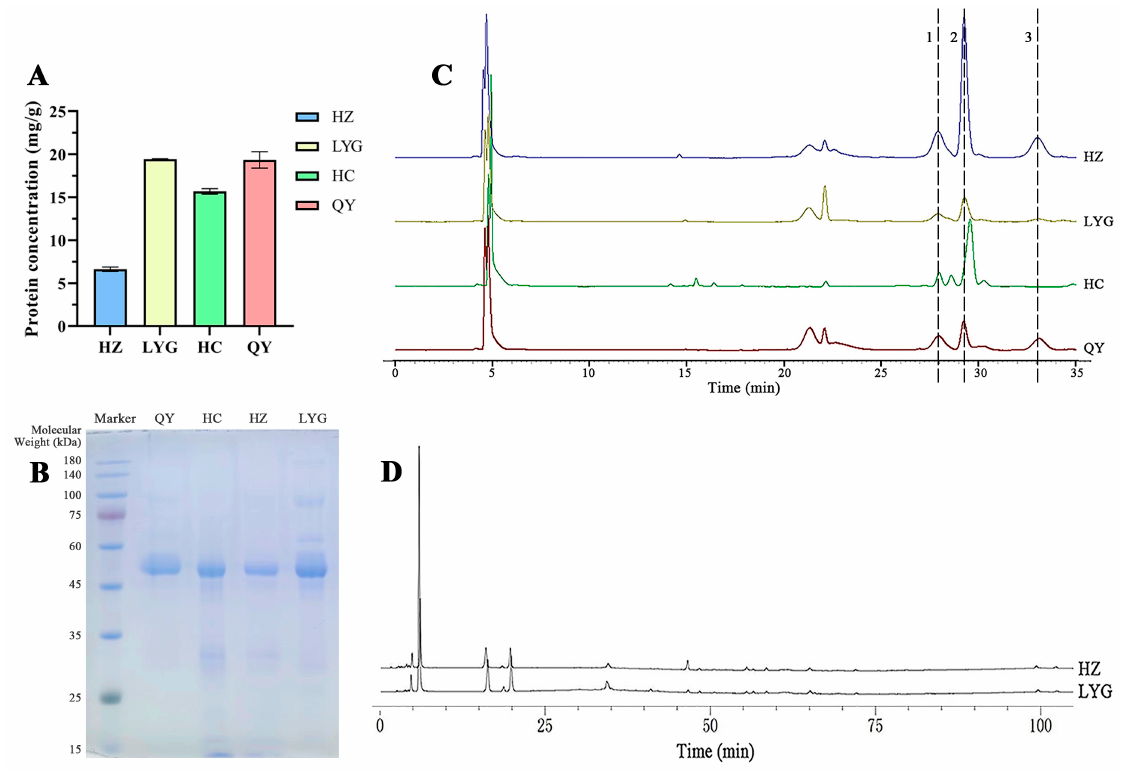
Figure 2. Composition differences between small molecular components and protein components of the venom of toads from different areas. ( A ) Protein quantification of toad venom from four areas. ( B ) Sodium dodecyl sulfate-polyacrylamide gel electrophoresis results of toad venom from four areas. ( C ) HPLC fingerprints of small molecular components of toad venom from four areas. 1: bufalin, 2: cinobufagin, 3: resibufogenin. ( D ) HPLC fingerprints of protein components of venom of toads from Hanzhong (HZ) and Lianyungang (LYG).